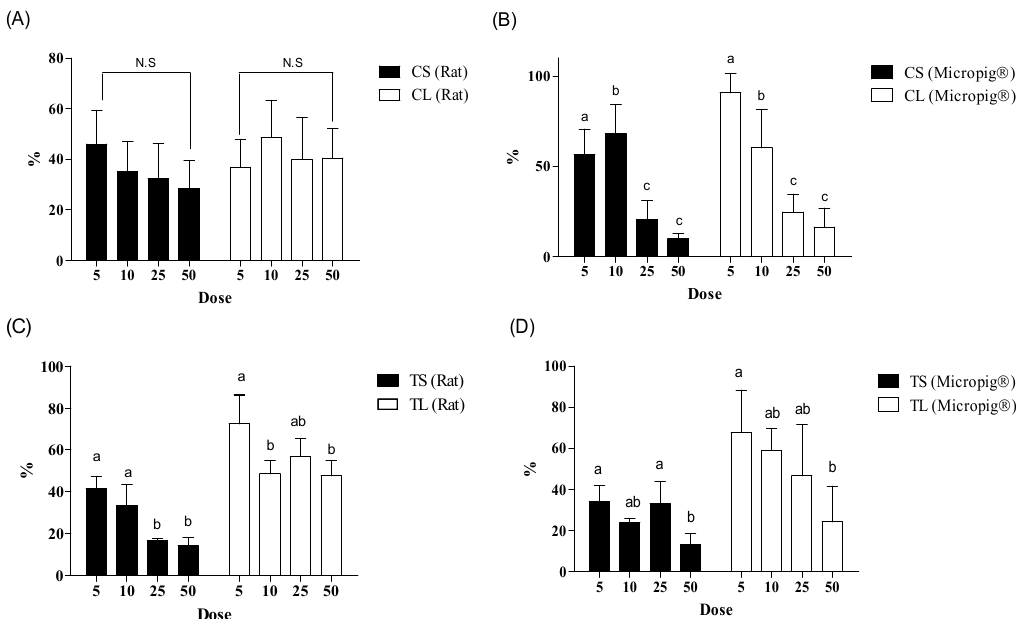
Figure 5. Comparing the dermal absorption rate (%, mean ± SD) of caffeine and testosterone, depending on the dose (5, 10, 25, and 50 mg/cm 2 or µL/cm 2 ). ( A ) Caffeine (rat), ( B ) caffeine (Micropig ® ), ( C ) testosterone (rat), and ( D ) testosterone (Micropig ® ). The same letter being written on the bar graph means no statistically significant difference in each data item (ANOVA with Tukey’s test; p = 0.05). CS, caffeine in cream formulation; CL, caffeine in solution; TS, testosterone in cream formulation; TL, testosterone in solution formulation; ANOVA, analysis of